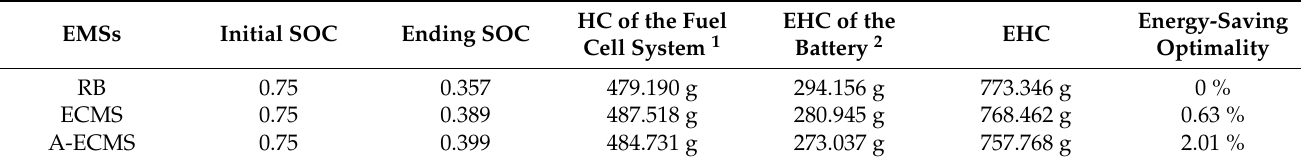
Table 2. General comparison of the simulation results under different EMSs.